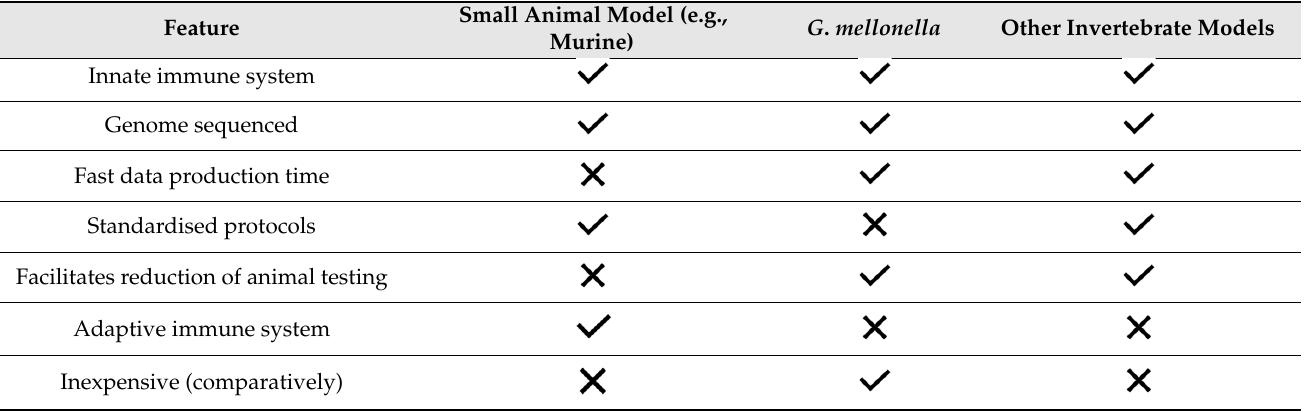
Table 1. Advantages and disadvantages of Galleria mellonella as in vivo model for research activities compared to the small animal model and other invertebrate in vivo models (e.g., Caenorhabditis ele- gans ( C. elegans ), Drosophila melanogaster fruit fly, and zebrafish ( Danio rerio ).